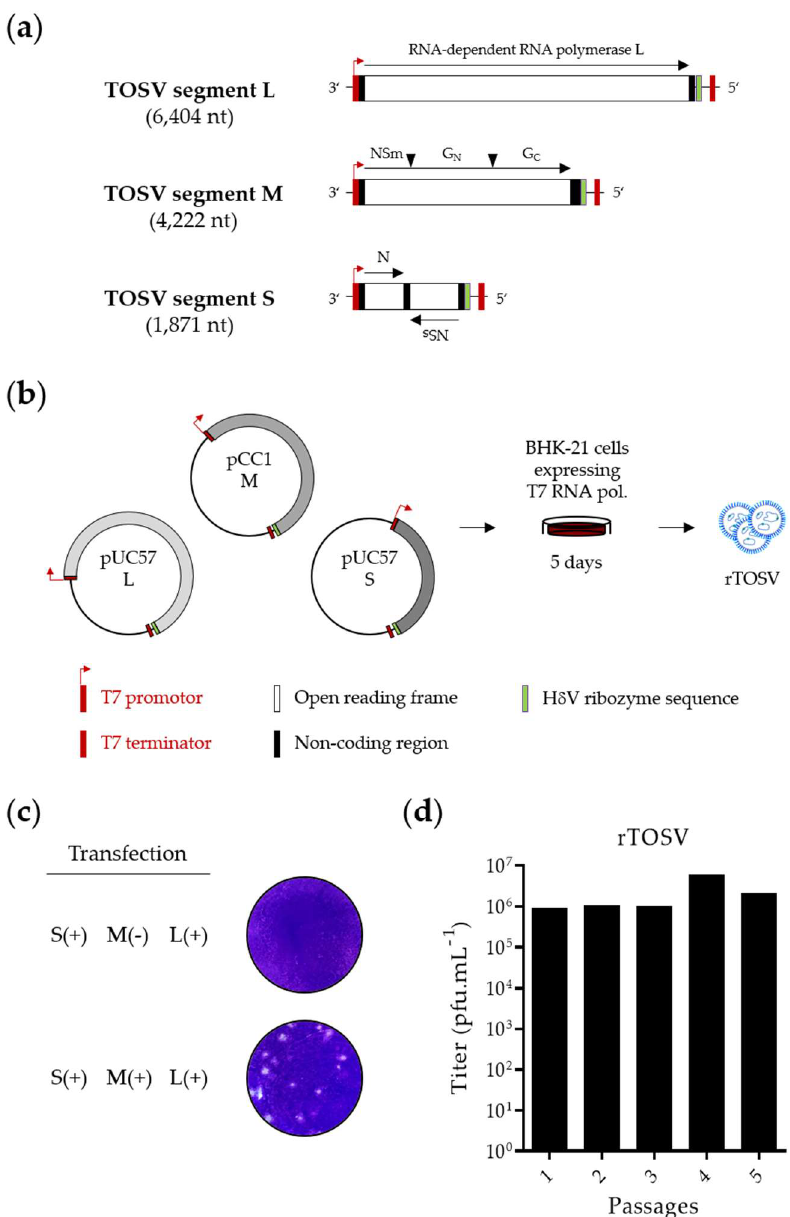
Figure 1. Rescue of Toscana virus (TOSV) from T7-driven plasmid DNAs. ( a ) The three negative-sense RNA genomic segments of TOSV strain H4906 (lineage B) were cloned between a T7 promoter and T7 terminator into the plasmids pUC57 (S and L) and pCC1 (M). A hepatitis delta virus (HdV) ribozyme sequence was introduced to generate authentic 3’ terminal ends. The black arrowheads mark cleavage sites in the M polyprotein precursor; ( b ) Schematic representation of the T7-driven TOSV rescue system; ( c ) Plaque-forming unit assays used for titration on BHK-21 cells of TOSV rescued from BHK-21 cells (rTOSV). After five days of incubation at 37 °C, plaques were visualized by crystal violet staining; ( d ) Titer of rTOSV after one passage in BHK-21 cells and four successive passages in Vero cells. nt, nucleotide; pfu, plaque-forming units; T7 RNA pol., T7 RNA polymerase.